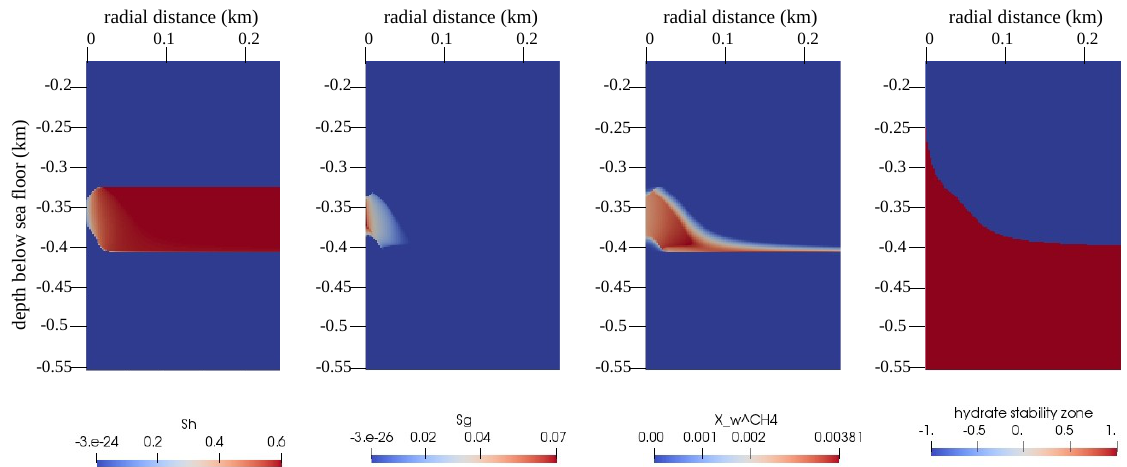
Figure 9. Numerical results for the reference test case of Example 2 (Section 4.2). The figure shows snapshots of the QoIs (from left to right: S h , S g , χ CH 4 w , and the GHSZ) within the domain of interest Ω I at t = t end = 360 days. Note that for the GHSZ, 1 indicates an unstable zone, and − 1 indicates a stable zone.